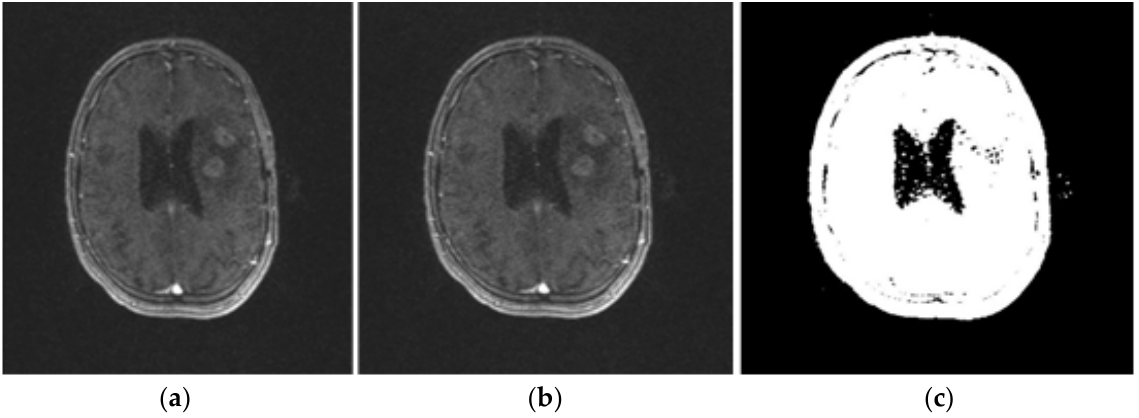
Figure 2. Rider dataset. ( a ) Original image; ( b ) converted grayscale; ( c ) binarized image.